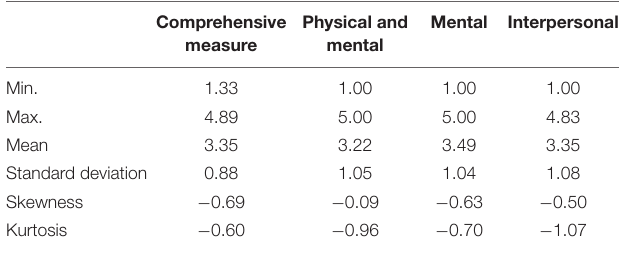
TABLE 3 | Residents’ mental vulnerability in the affordable housing community of Fanghe